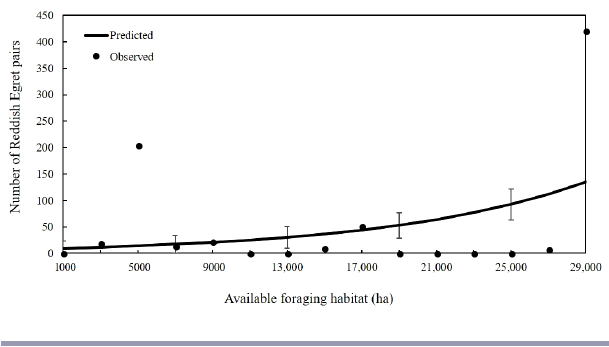
Fig. 4 . Results of negative-binomial generalized model showing the mean number of observed Reddish Egret ( Egretta rufescens ) breeding pairs and the mean (± 95 confidence interval) number of predicted pairs at a colony in relation to the amount of available foraging habitat within 15 km of the colony. Model: Reddish Egret pairs = foraging habitat + density of